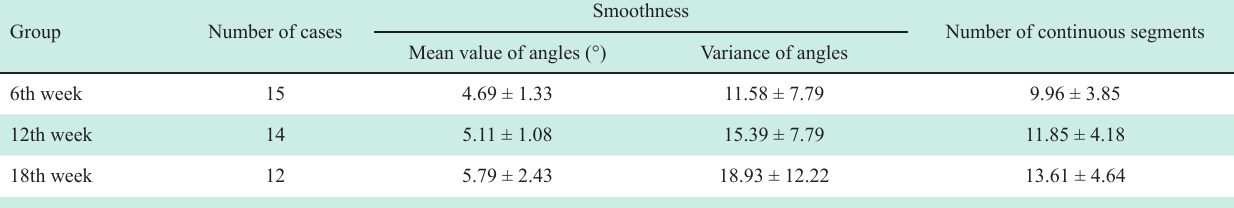
Table 1 Comparison of continuity and smoothness of the hepatic capsule ( x ± s ) Group